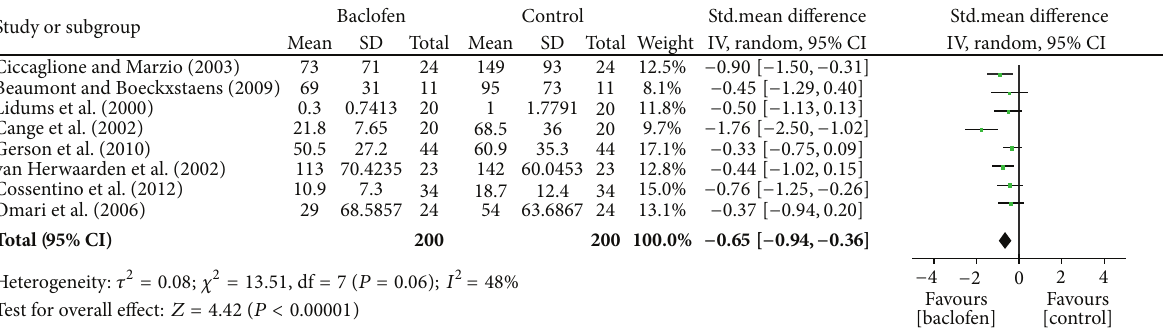
Figure 2: Meta-analysis of the incidence of GER in the PP population given either baclofen or placebo for the treatment of GERD.